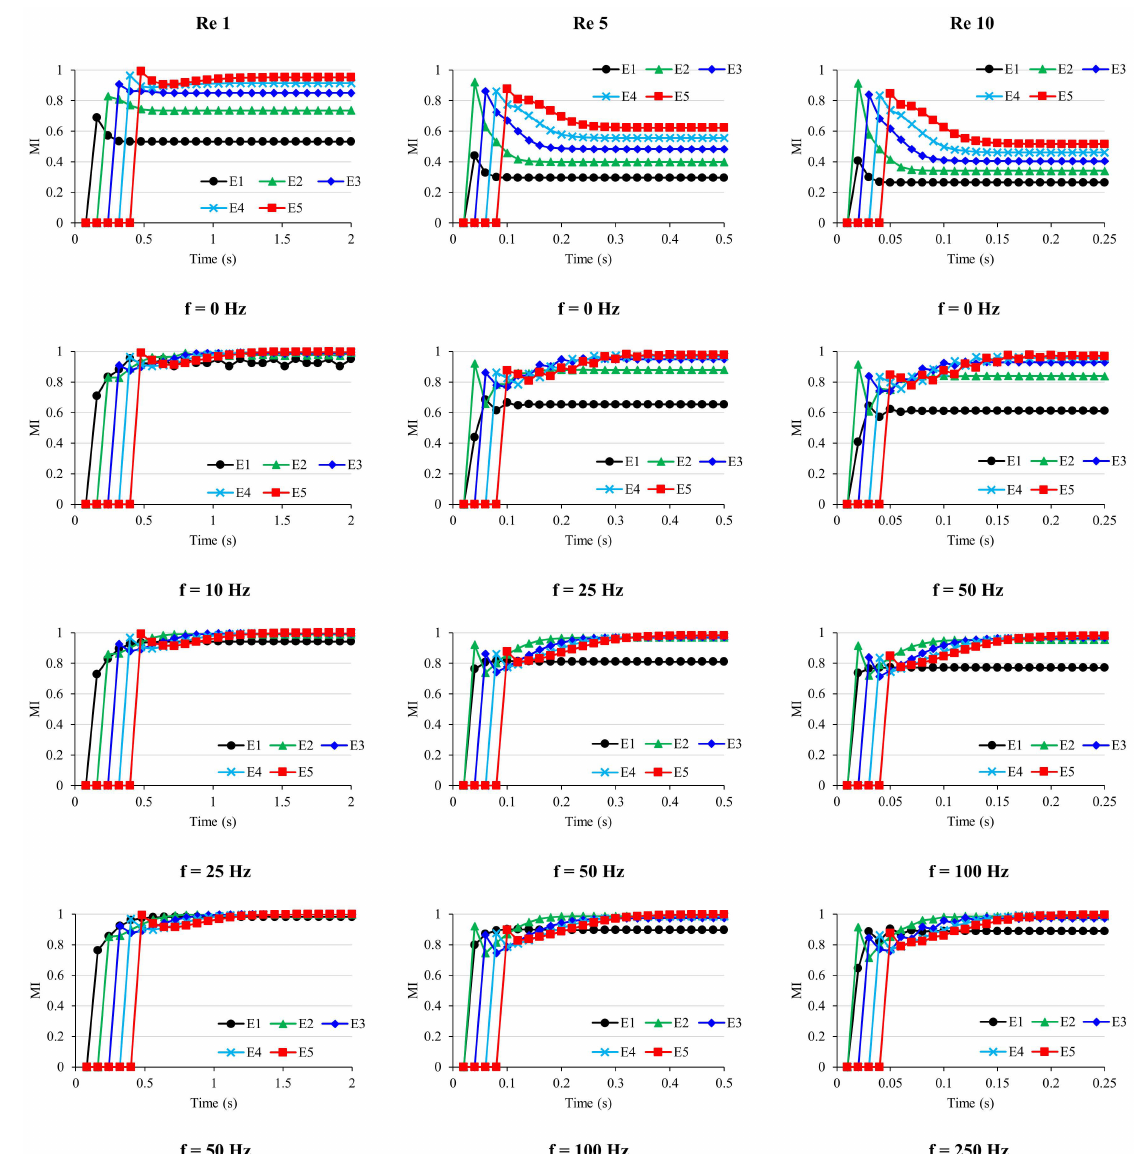
Figure A8. The development of fluid mixing with respect to time at the exit of mixing units in the CSFO–C micromixer configuration when Re = 1, 5, and 10 and D = D 1 . f = 0 Hz plots ( first row ) show time-dependent solutions of CSFO–A micromixer. MI values are calculated on the E1, E2, E3, E4, and E5 cross-sections which are normal to the